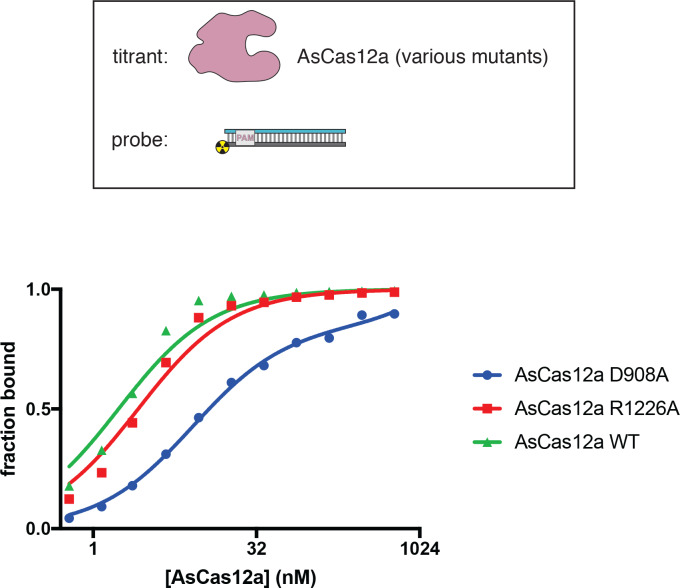
Affinity measurements for RNA-guided interaction of AsCas12a mutants with dsDNA.The affinity of AsCas12a/crRNA for a cognate DNA target was assessed by a filter-binding assay, with three variants of AsCas12a. AsCas12a was titrated in a solution with fixed [crRNA] (750 nM) and [DNA probe] (100 pM), in binding buffer containing MgCl2, followed by separation of protein-bound DNA from free DNA on membranes. ‘Fraction bound’ is defined as (volume of Protran spot)/(total volume of Protran spot + Hybond N+ spot). The value of ‘fraction bound’ was 0 at [AsCas12a]=0 for all protein variants (not shown due to the logarithmic x-axis). All data shown are from a representative replicate (n = 3). Data were fit to the sum of a hyperbola and a line (y = Bmax*x/(KD+x)+NS*x), where NS describes a non-specific binding mode. It is common to see Bmax values below 1 in filter-binding assays, in which the process of physical separation can disrupt bound species. KD for AsCas12a D908A was 11 nM ±3 (SD) (n = 3). KD for AsCas12a R1226A was 2.7 nM ±0.2 (SD) (n = 3). KD for AsCas12a WT was 1.86 nM ±0.04 (SD) (n = 3).